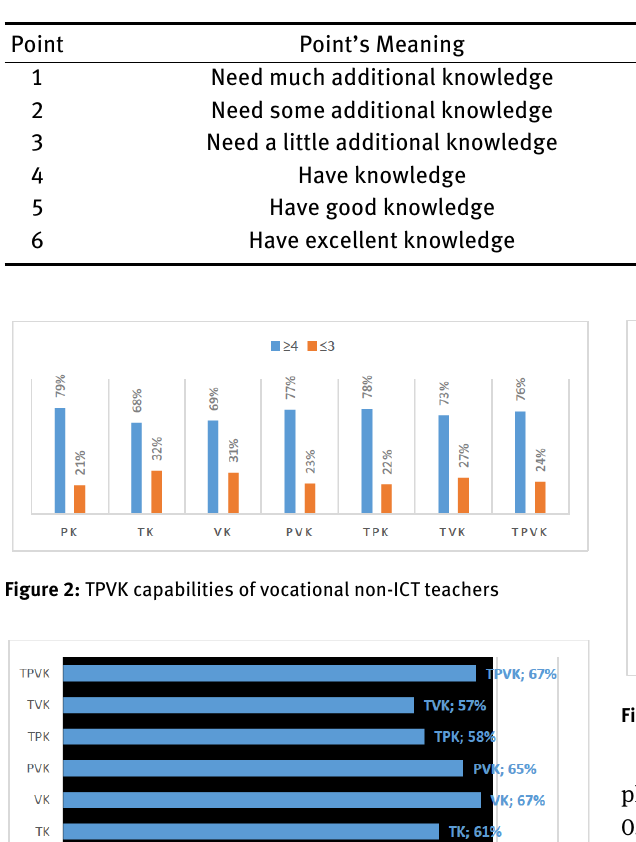
pha for inter-rater reliably in four criteria were 0.747, 0.722, 0.751, and 0.707, responsively. The intraclass